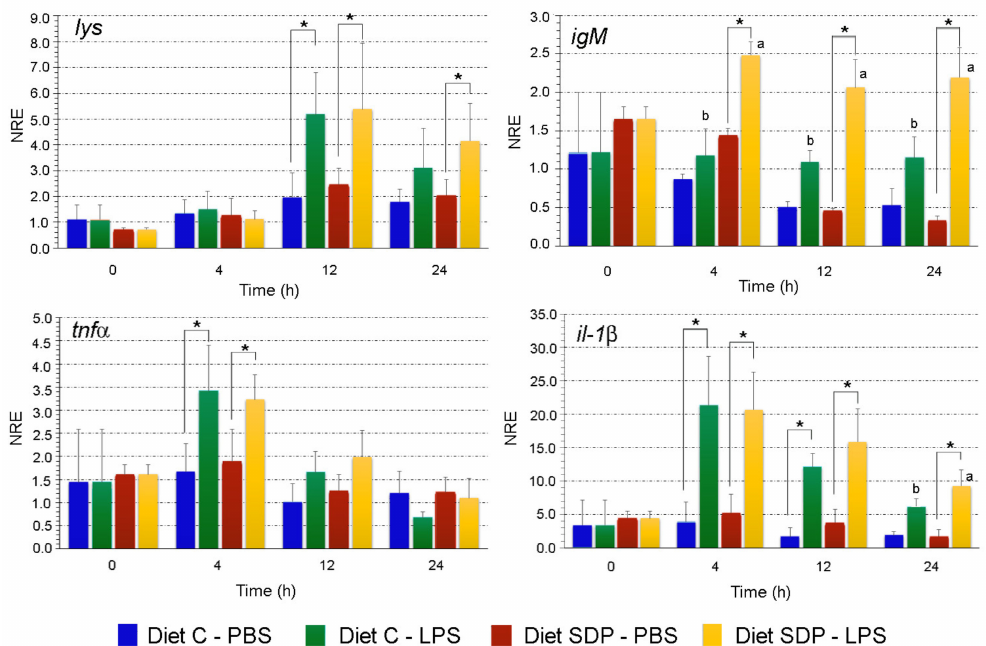
Figure 2. Gene expression analysis of humoral innate response markers measured in primary cultures of splenocytes incubated with PBS or LPS. The gene expression ( n = 6) of lysozyme ( lys ), immunoglob- ulin M ( igM ), tumor necrosis factor alpha ( tnf α ), and interleukin 1 β ( il-1 β ) from splenocytes of gilthead sea bream ( Sparus aurata ) fed with a control diet (Diet C) with very low levels of fishmeal (7%) and a diet in which 5% fishmeal was replaced with spray-dried porcine plasma (SDPP diet). Gene expres- sion was measured in primary cultures of splenocytes from both groups exposed to PBS and LPS at different sampling times (0, 4, 12, and 24 h after LPS or PBS incubation). The analysis used the β -actin as the reference gene. Data were compared by means of a two-way ANOVA. Different letters indicate statistically significant differences between splenocytes from different experimental groups (C and SDPP diets) at the same sampling time. The asterisk indicates the presence of statistically significant differences between splenocytes incubated with PBS or LPS within the same experimental group ( p <